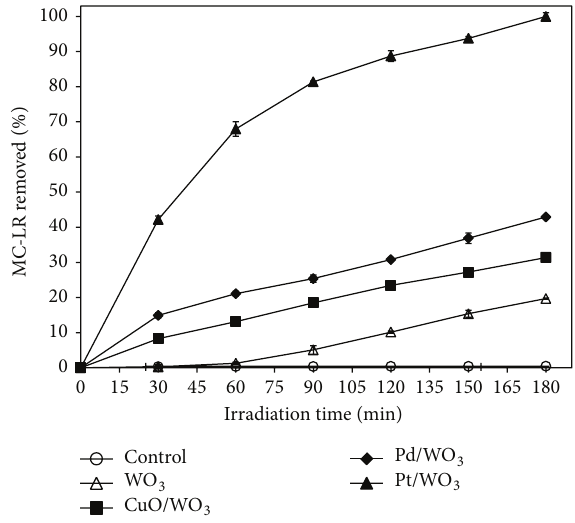
Figure 3: The effect of catalysts on the efficiency of photocatalytic degradation of MC-LR. (Experimental conditions: MC-LR concen- tration of 1mg L −1 , catalyst concentration of 100 mgL −1 , and simu- lated solar light intensity of 0.4mWcm −2